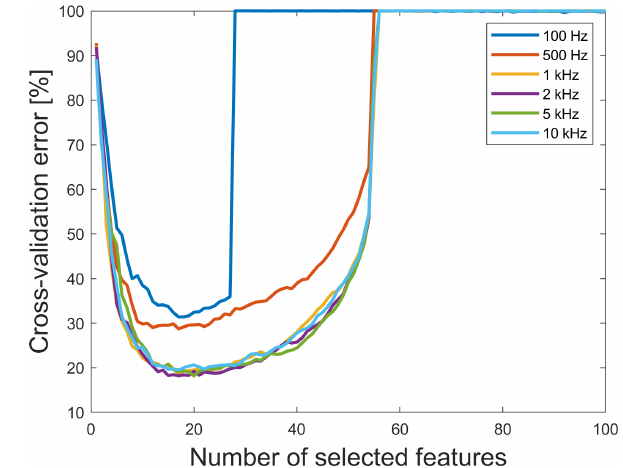
Figure 5. The 10-fold cross-validation error vs. number of selected features for data sets with different sampling rate using BFC as ex- tractor and RFESVM as selector. Table 1. Cross-validation error for different FE/FS combinations. FS/FE Pearson RFESVM